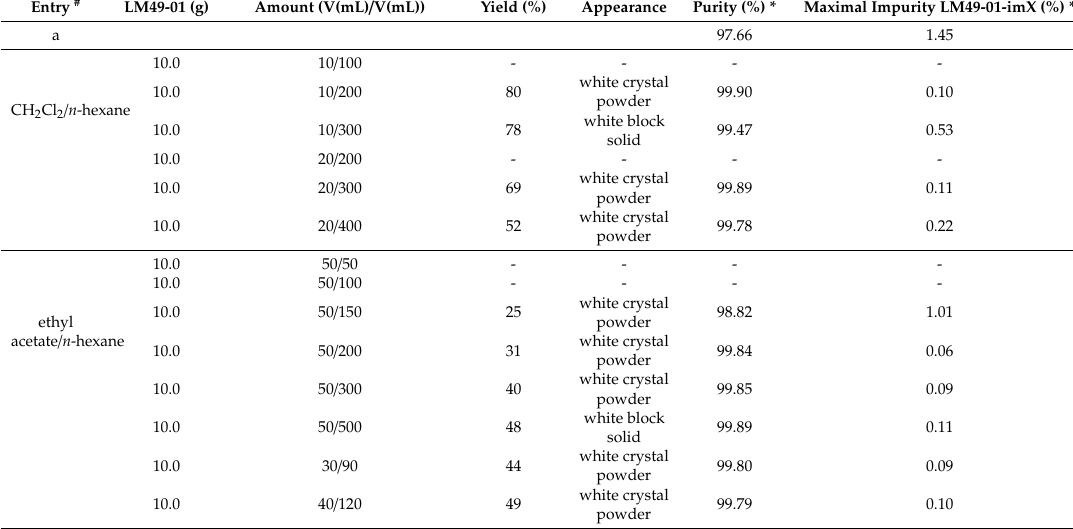
Table 2. Screening of purification conditions for LM49-01